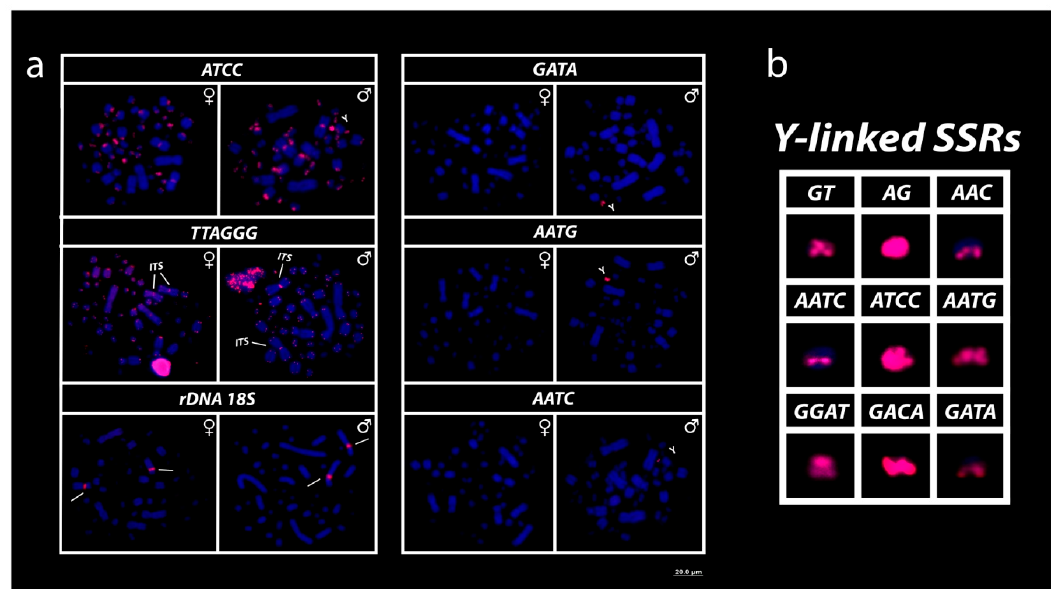
Figure 4. Mapping of several SSRs, telomeric (TTAGGG) n , and 18S rDNA on the chromosomes of males and females of R. rufipes ( a ). ( b ) Different patterns of SSR motif recruitment to enlarged forms of micro Y sex chromosome. Bar = 20 µm.